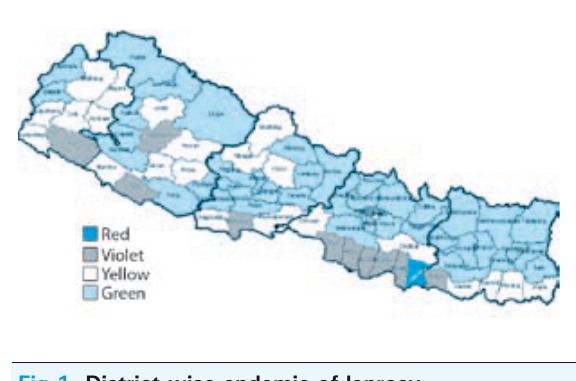
Fig 1. District wise endemic of leprosy